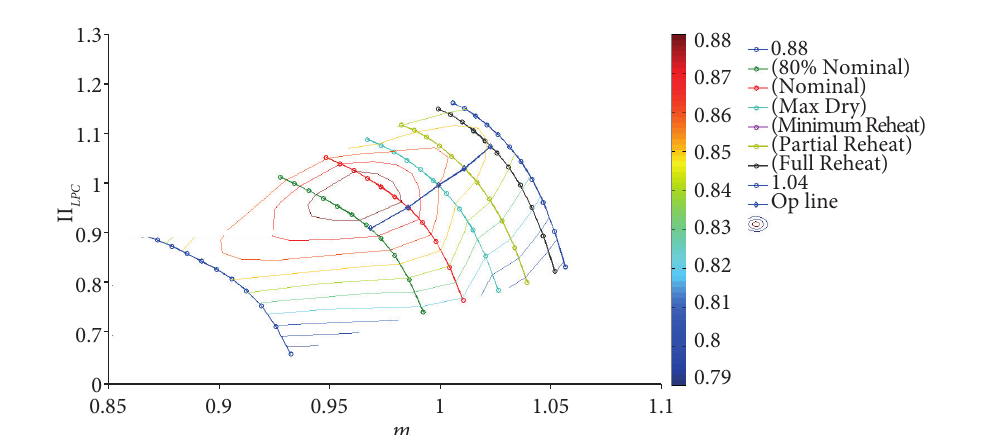
Figure 10. HPC map with efficiency contours scaled using multipoint scaling, so that efficiencies from the map agree with experimental data.